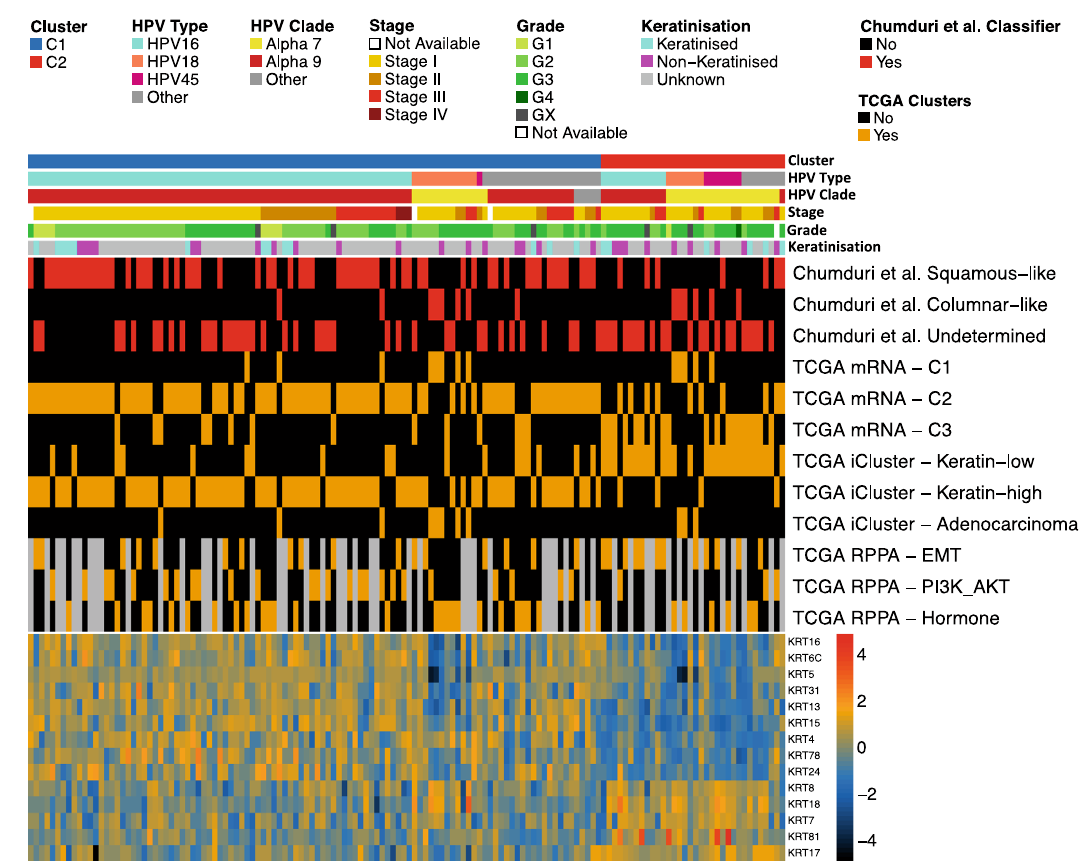
Fig. 3 | Comparison of SCC subgroups with previous studies. Cluster analysis had previously been performed on 140 TCGA SCC tumours in two studies – one determined clusters based on cell of origin markers (Chumduri et al., 2021, red), and one determined clusters based on integrated omics data (TCGA Network, 2017, orange). Patients (columns) are identi fi ed as belonging to one of the clus- ters identi fi ed by Chumduri et al by red in the appropriate row and belonging